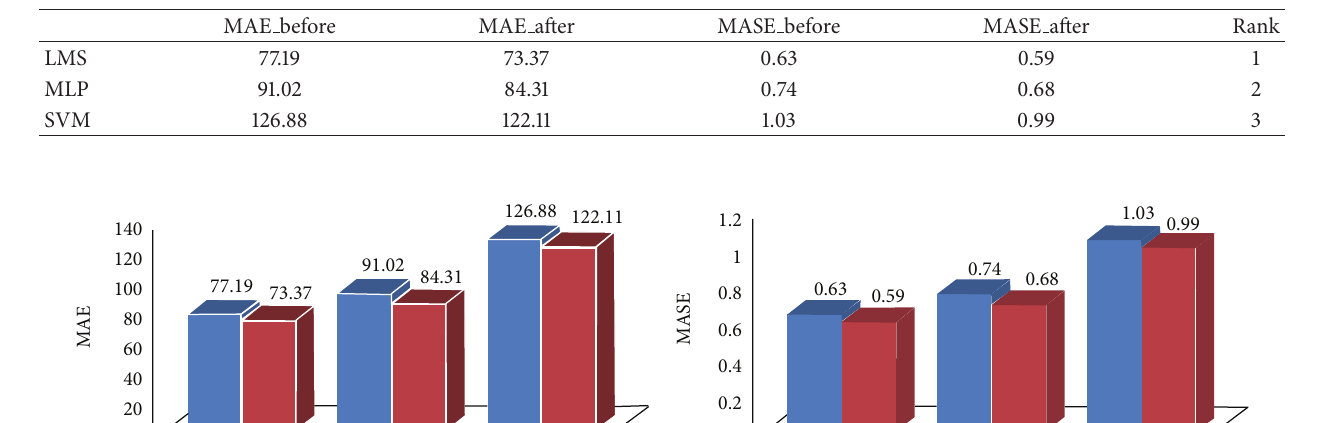
Table 6: Error measurements of the top most three decisive regression algorithms’ prediction accuracy with feature selection.